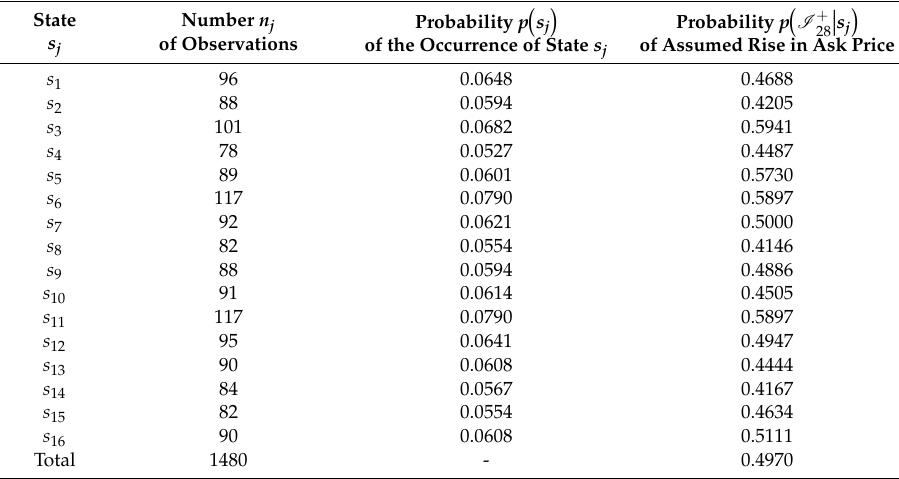
Table 2. Prediction table P ( XAG/USD,28, E 4 , Ξ 1 , Ψ 1 )